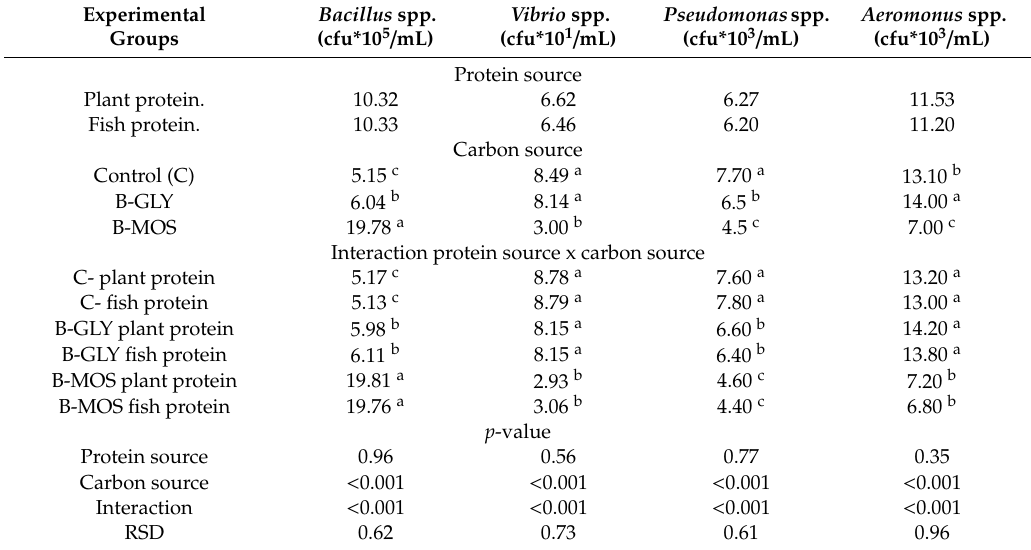
Table 6. The e ff ect of di ff erent dietary protein sources and carbon sources on Nile tilapia ( O. niloticus) intestinal bacterial count.